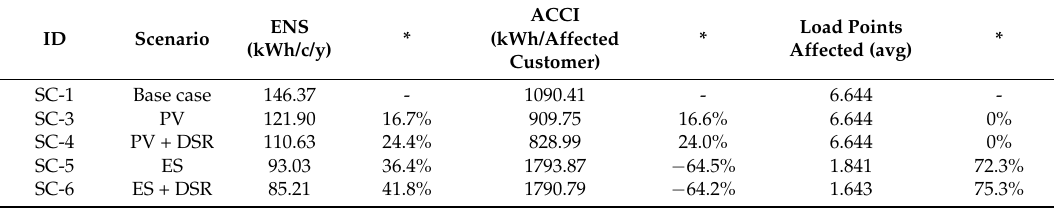
Table 6. Energy not supplied and customer curtailment indices.